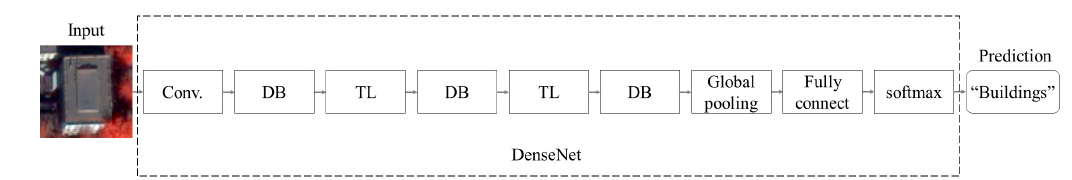
Figure 6. A DenseNet composed of three DBs.